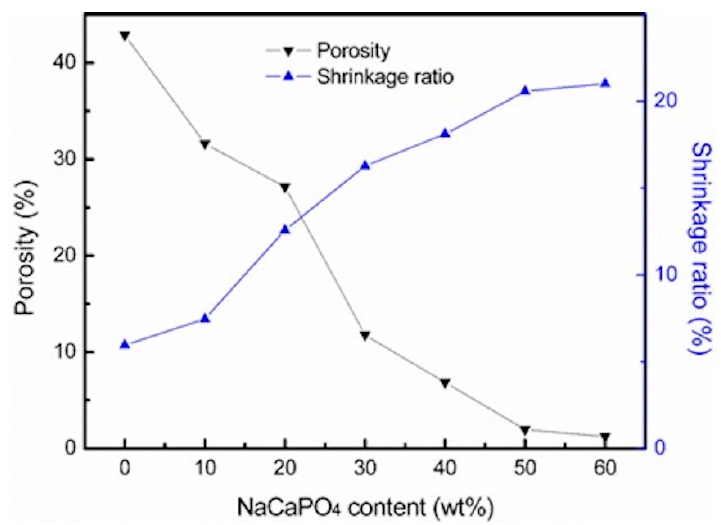
Figure 5. Porosity and volume shrinkage ratio of samples at different NaCaPO 4 weight ratios. The OM images used to measure the marginal gap of samples 7Z3N and 6Z4N that were sintered at 950 °C and 1350 °C for 4 h, respectively, are shown in Figure 7, with the marginal integrity revealing that sintering at 1350 °C is better than that at 950 °C (Figure 7a). The marginal discrepancy of samples 7Z3N and 6Z4N sintered at 1350 °C for 4 h are also observed, revealing that sample 6Z4N is slightly damaged on the occlusal edge. Compared with sample 7Z3N, sample 6Z4N has a more significant discrepancy over the distal marginal area (Figure 7b).